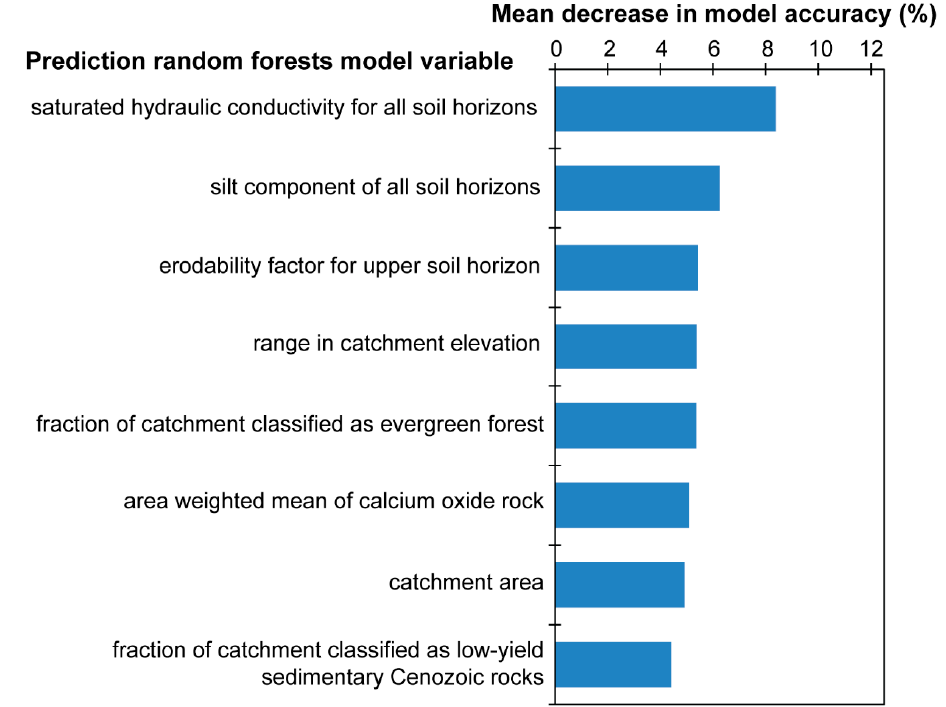
Figure 6. Mean decrease in predictive model accuracy for the eight most important variables for the predictive random forests model that produced the optimized combined out-of-bag and N class error